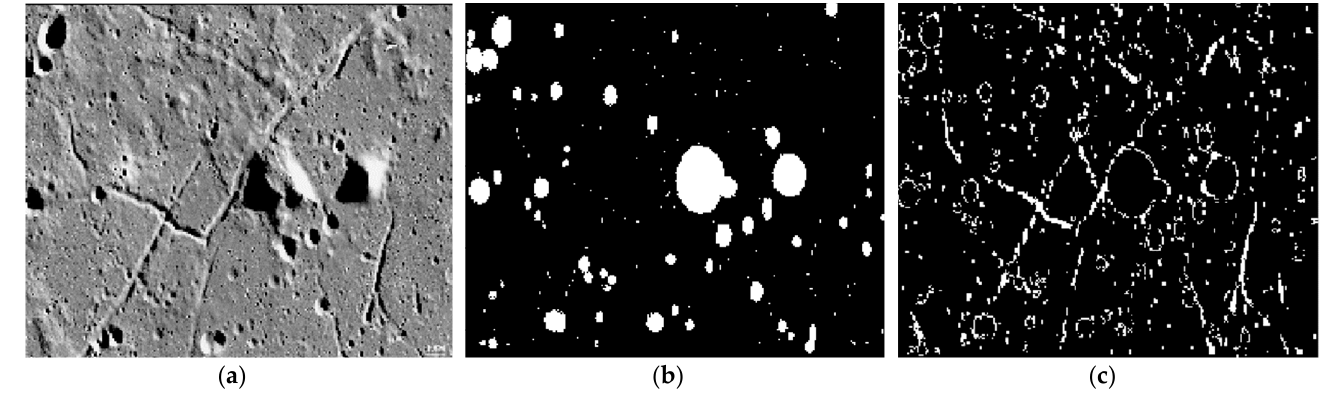
Figure 11. On the lunar surface, prediction results of the assembled data set from the National Aeronautics and Space Administration (NASA) and China National Astronomical Observatory’s published online library. ( a ) Moon surface image. ( b ) Ground truth of craters. ( c ) Prediction of craters and rilles.